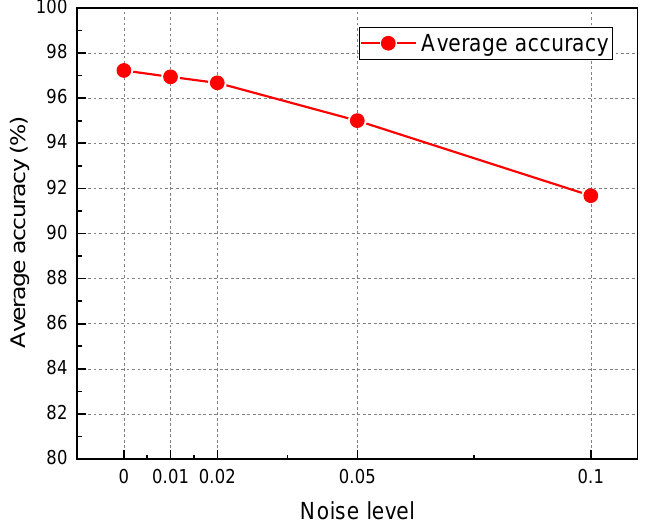
Figure 13. Recognition accuracy under different noise levels.